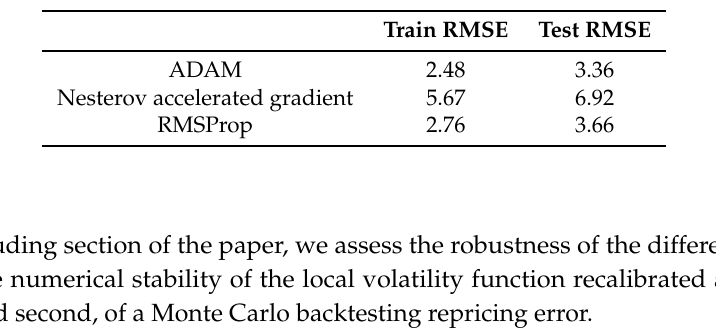
Table 6. Pricing RMSEs corresponding to different stochastic gradient descents (soft constraints approach with dense network and Dupire penalization).